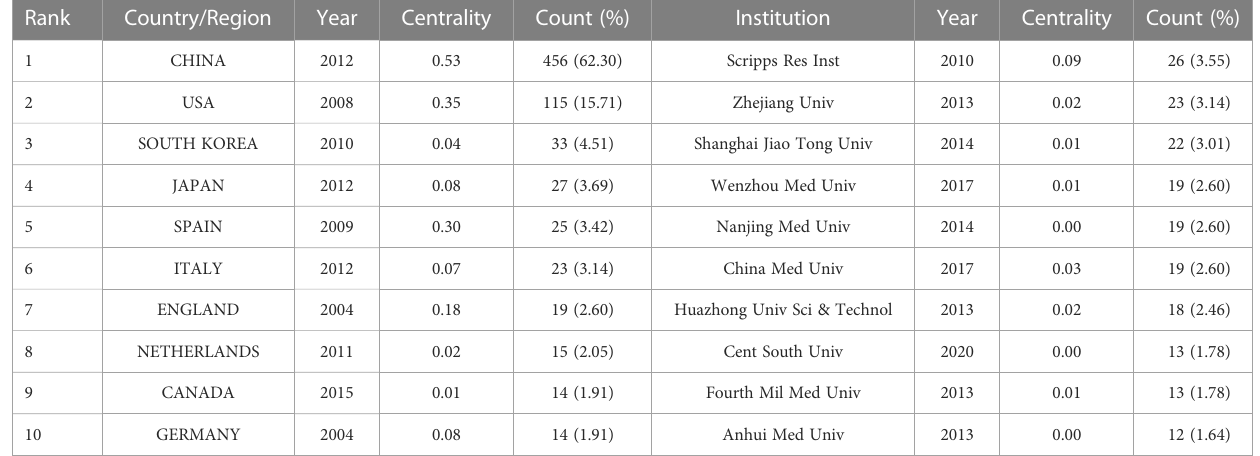
TABLE 2 Distribution of publications on autophagy in OA from different countries/regions and institutions. Rank